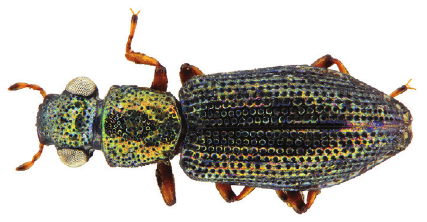
Figure 5. Hydrochus sp. 1